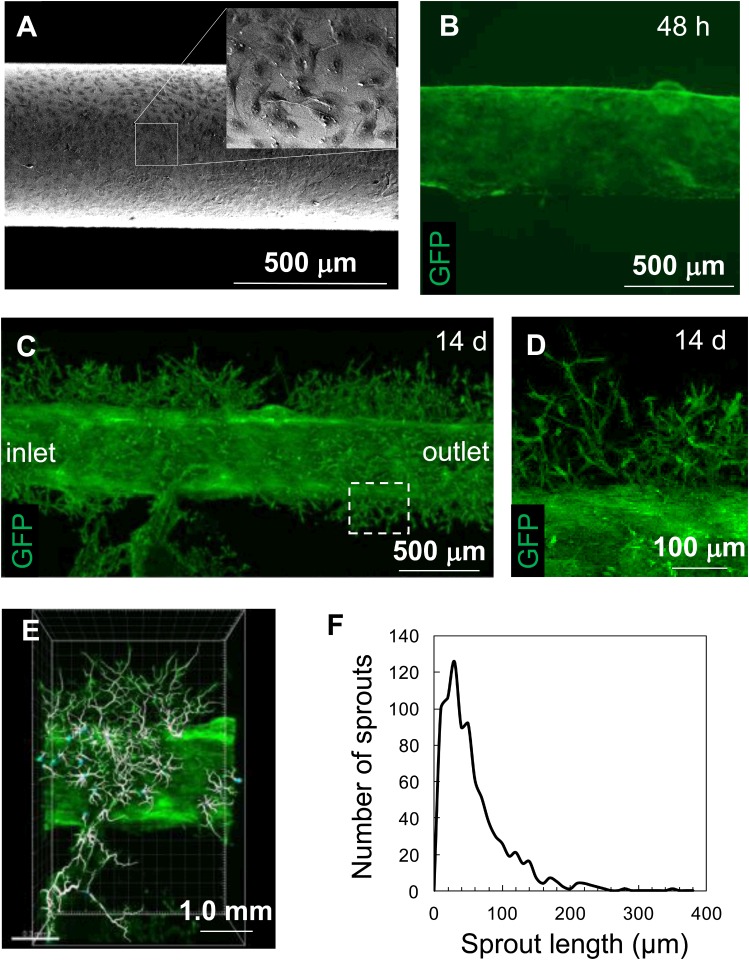
Endothelial cell sprouting in collagen gel under stationary culture conditions in a culture dish.(A) SEM image of HUVECs on a gold rod prior to cell transfer. The inset is a magnified view. (B) HUVECs transferred onto the internal surface of a microchannel in collagen gel after 48 h of culture. (C, D) HUVECs migrating into the collagen gel at 14 d. The box in (C) indicates the location of (D). (E, F) Image analysis. Sprouts were traced and quantified using image analysis software (E, S1 Movie). The sprout length was quantified at 21 d (F).